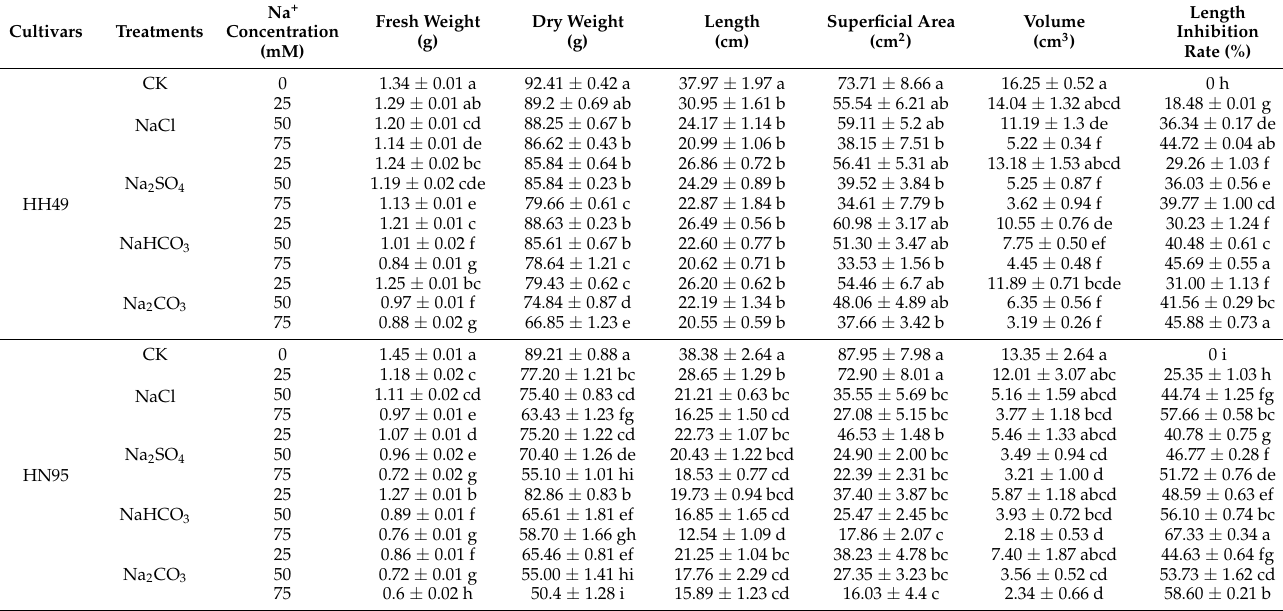
Table 1. Effects of different salt treatments on root growth of HH49 and HN95